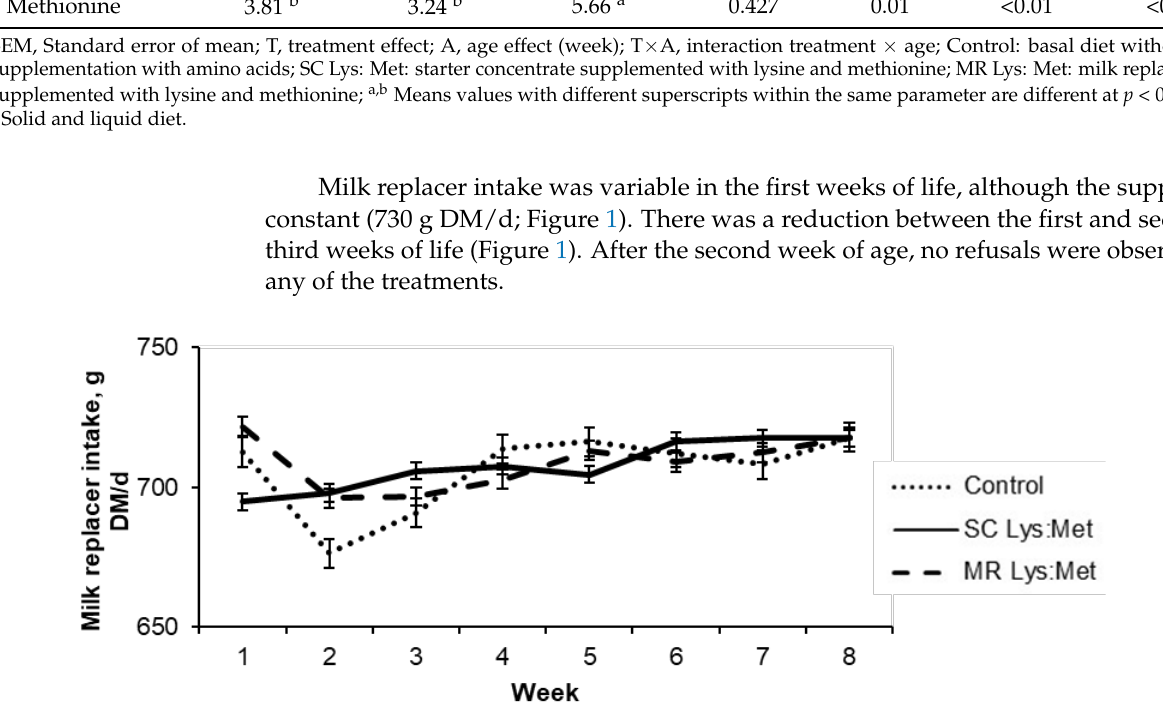
Figure 1. Milk replacer intake in dairy calves with or without lysine and methionine supplementation in starter concentrate or milk replacer. Error bars indicate standard error of the mean.